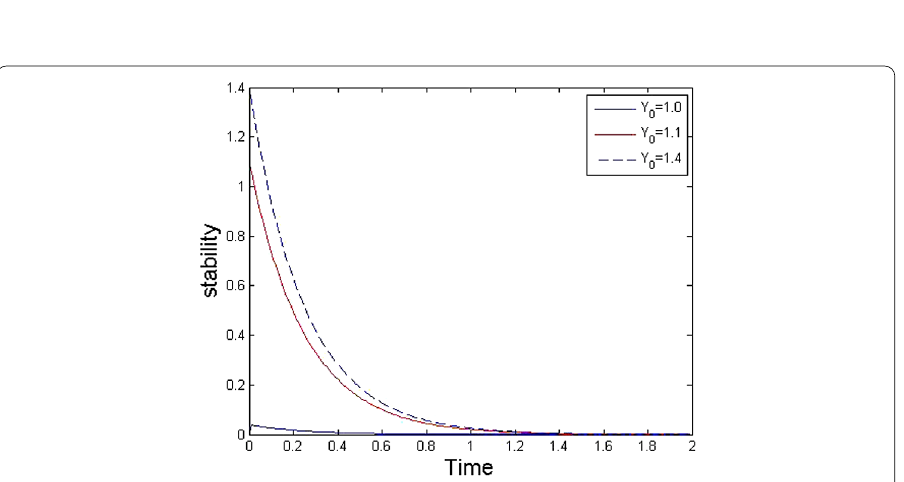
Figure 3 Stability of the ECI